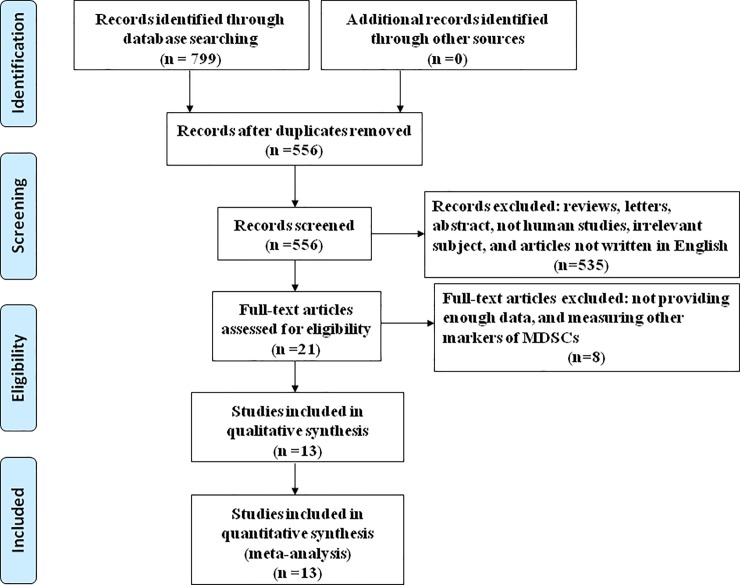
Flowchart summarizing literature search strategy and selection of studies.